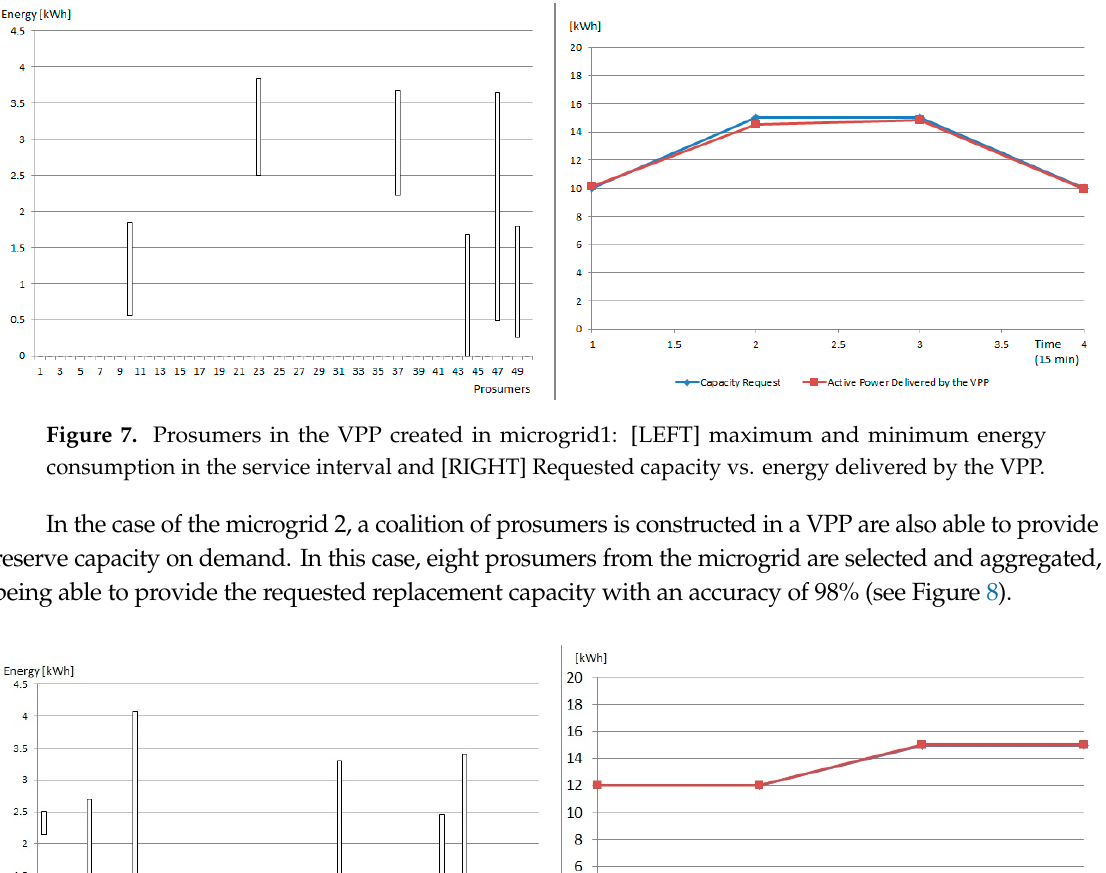
Figure 9. [LEFT] Prosumers selected in the VPP coalition from microgrid3 and [RIGHT] VPP energy generation and energy price in the market. Afterwards, the model will address the low power factor in microgrid 4 by constructing a second level VPP with the aim of virtually aggregating the surplus of active power available at each microgrid level to improve the power factor from the low level of 0.75 and get it as close as possible to the optimal value of 1.